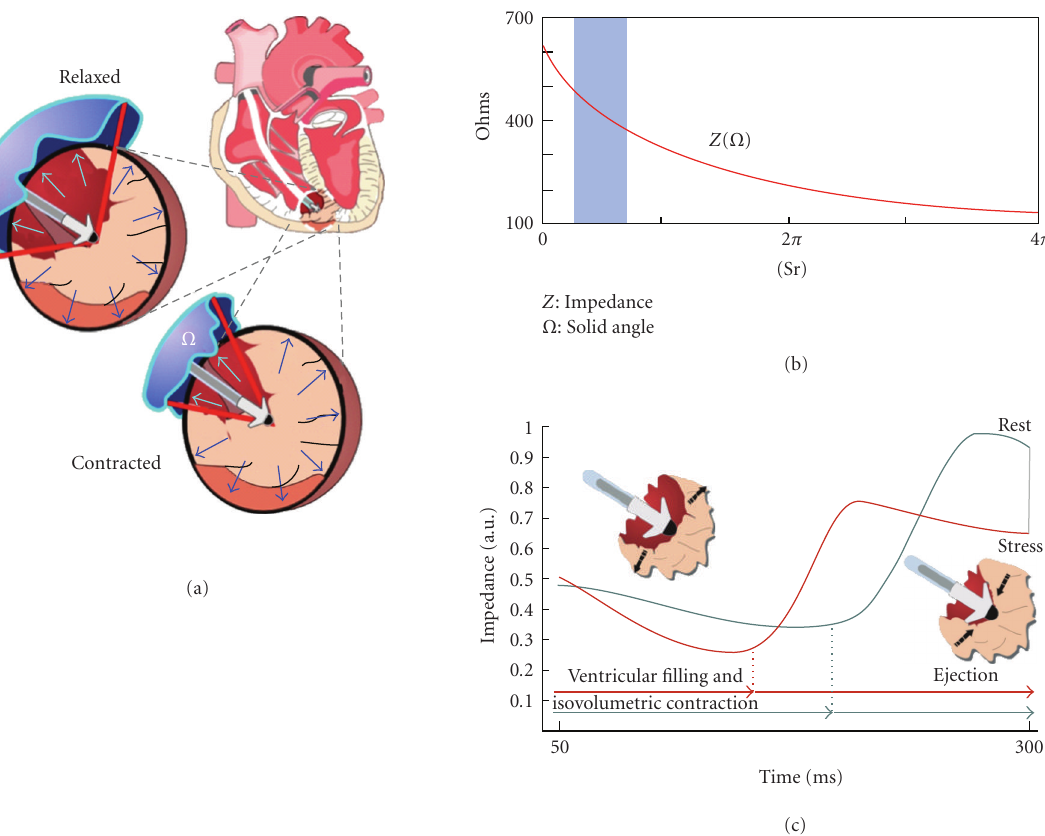
Figure 2: Closed Loop Stimulation (CLS) system (Biotronik, Germany). (a) Changes in intracardiac impedance are closely related to myocardium-blood ratio in the volume around the ventricular tip. (b) An increase in blood volume (and the consequent solid angle) produces a decrease in intracardiac impedance (Z). (c) An enhanced contractility induces an increase of impedance around the electrode tip (morphological modification of impedance curve moves it to the